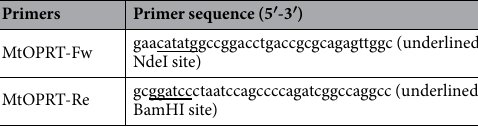
Table 1. Primers used in this study.